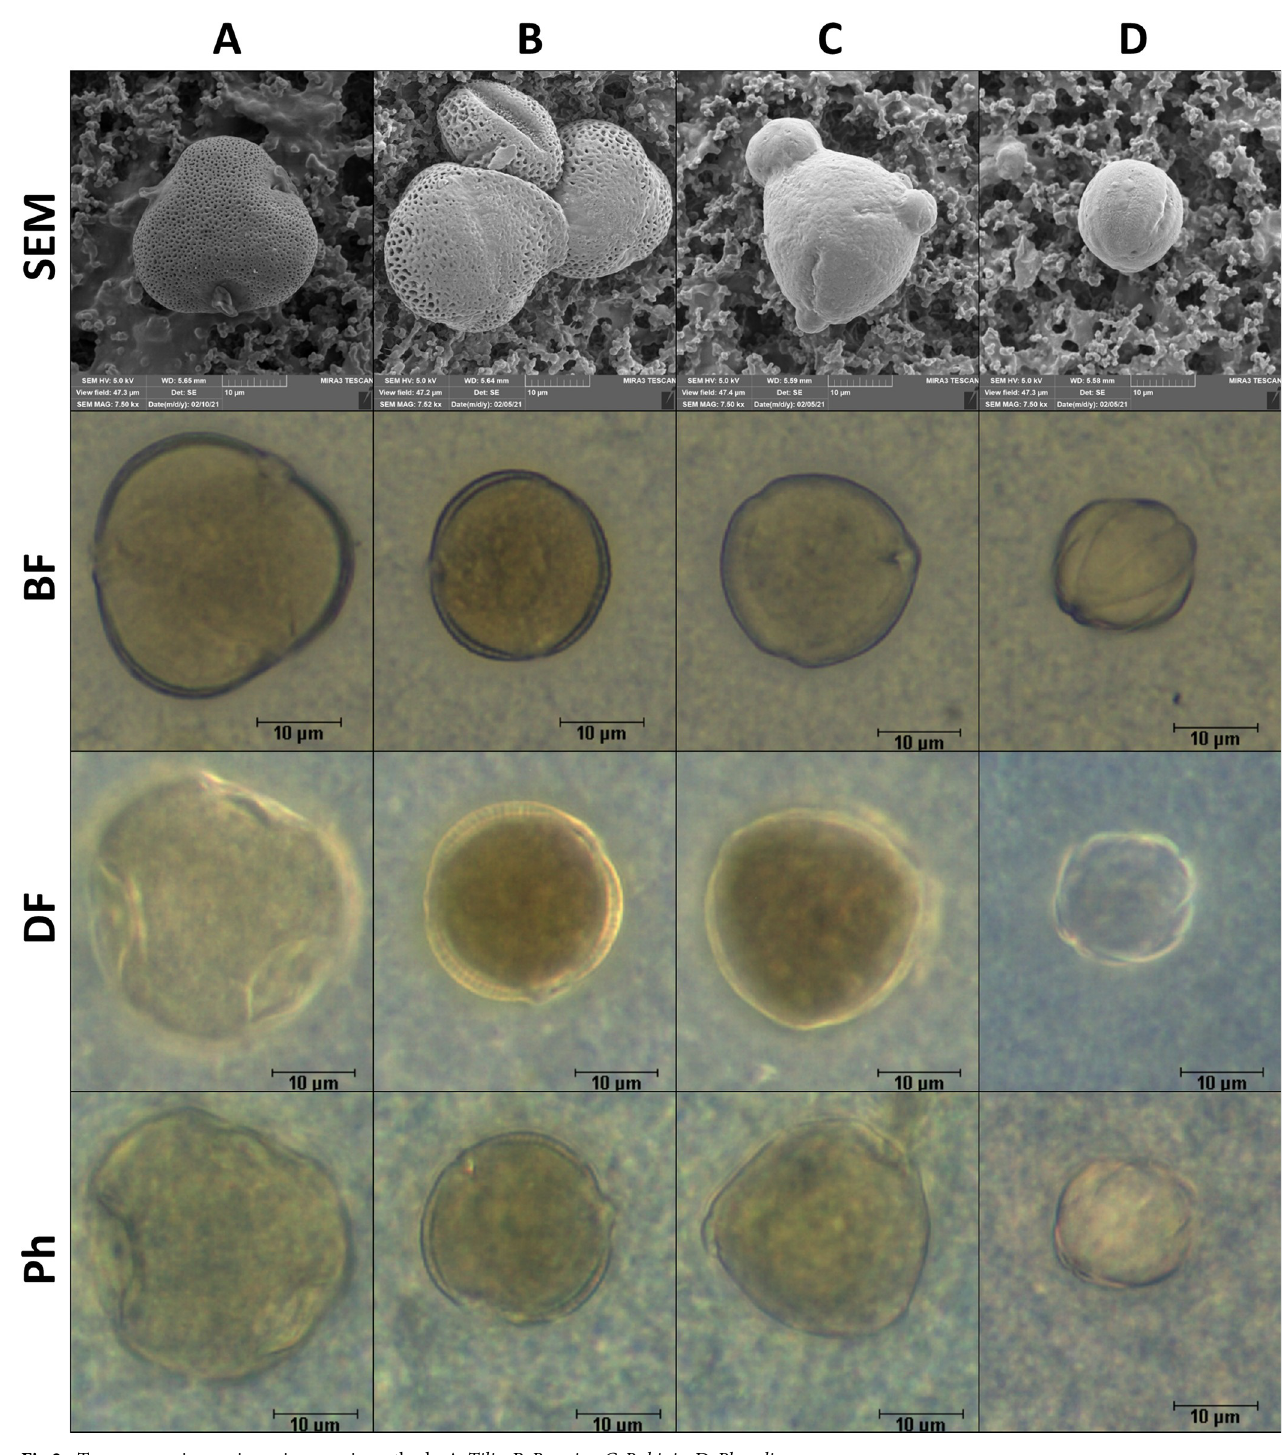
Fig 2. Taxa comparison using microscopic methods, A- Tilia ; B- Brassica ; C- Robinia ; D- Phacelia . various reasons for this variability [42]. The length is the common descriptor used for pollen classification based on image processing and manual classification. The length of the pollen can be affected by sample preparation which causes differences between values published